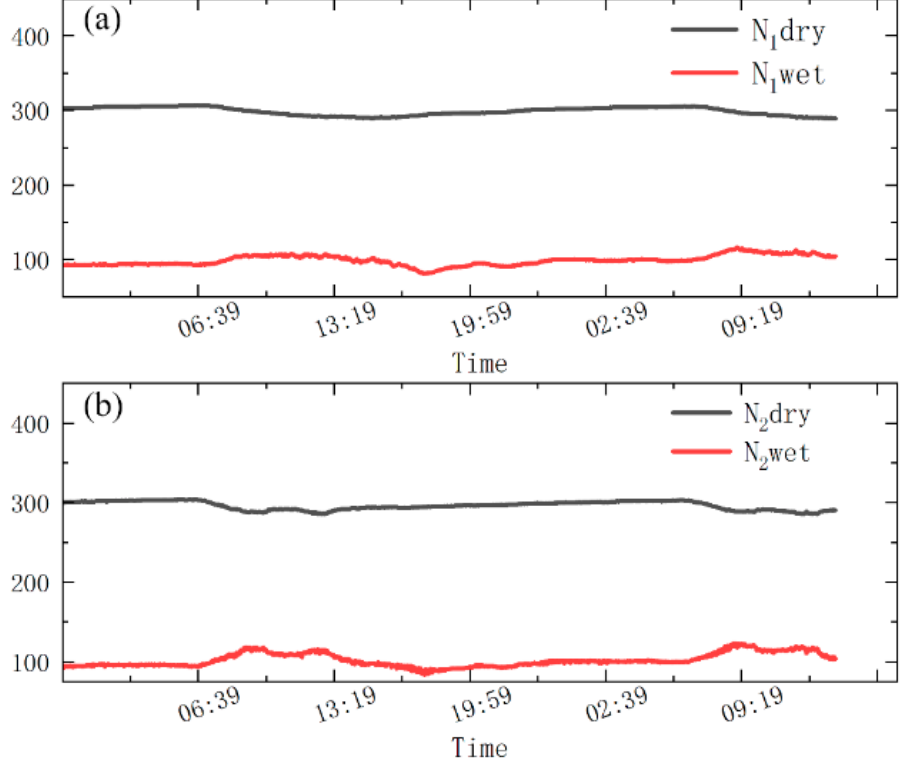
Figure 2. The dry and wet components of the refractivity index from 0:00 h on 15 October 2022 to 13:56 h on 16 October 2022. ( a ) The refractivity index of P1. ( b ) The refractivity index of P2.